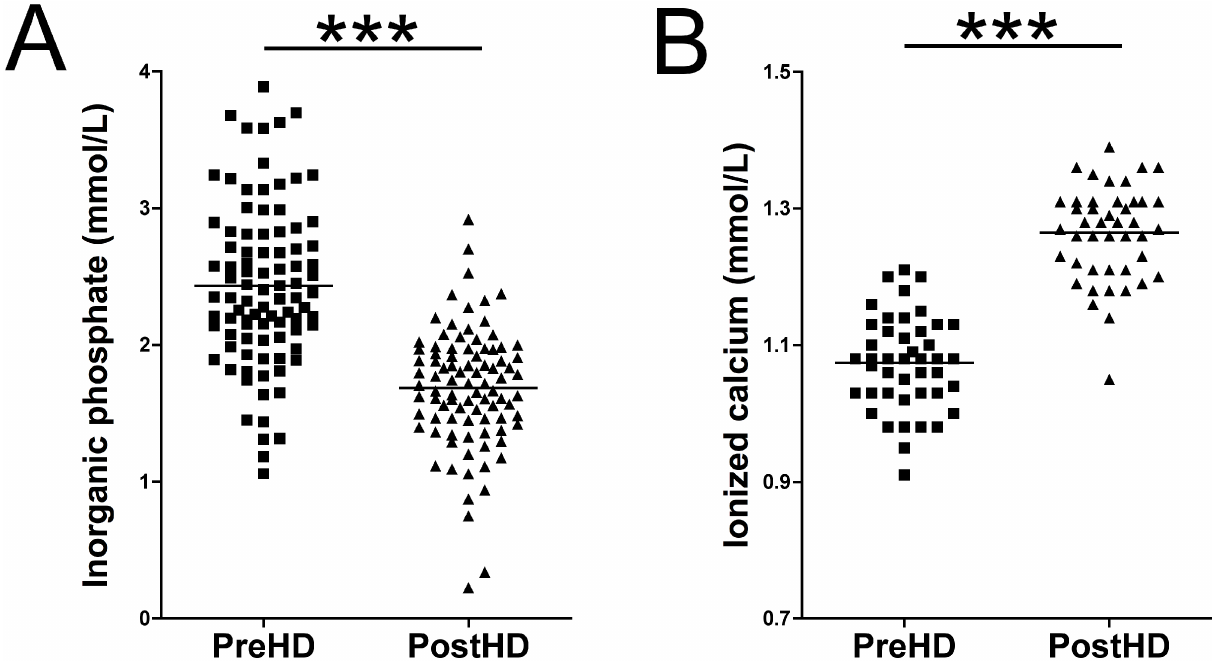
Fig 2. Inorganic phosphate and ionized calcium concentration in haemodialysis patients. ( A ) Plasma phosphateconcentration in pre- and post-haemodialysissamples (n = 92). ( B ) Plasma ionizedcalcium concentration in pre- and post-haemodialysissamples (n = 45). The Wilcoxon matched pairs test (pre- versus post-haemodialysis)was used for statistical analysis. *** p < 0.001 . PreHD , pre-haemodialysis; PostHD , post-haemodialysis.